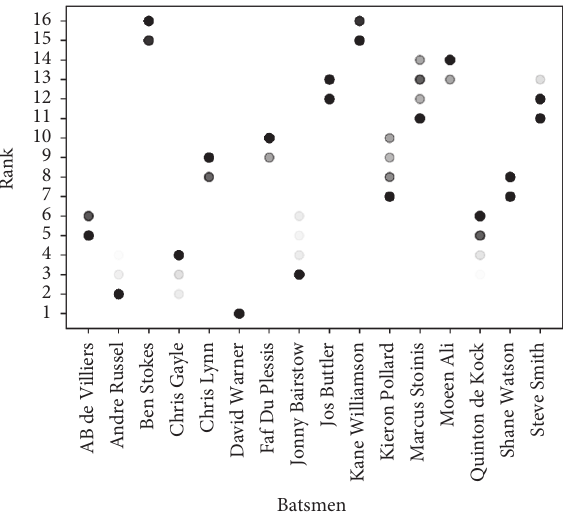
Figure 7: Heat map for batsmen ranks by TODIM through shuffled weights.